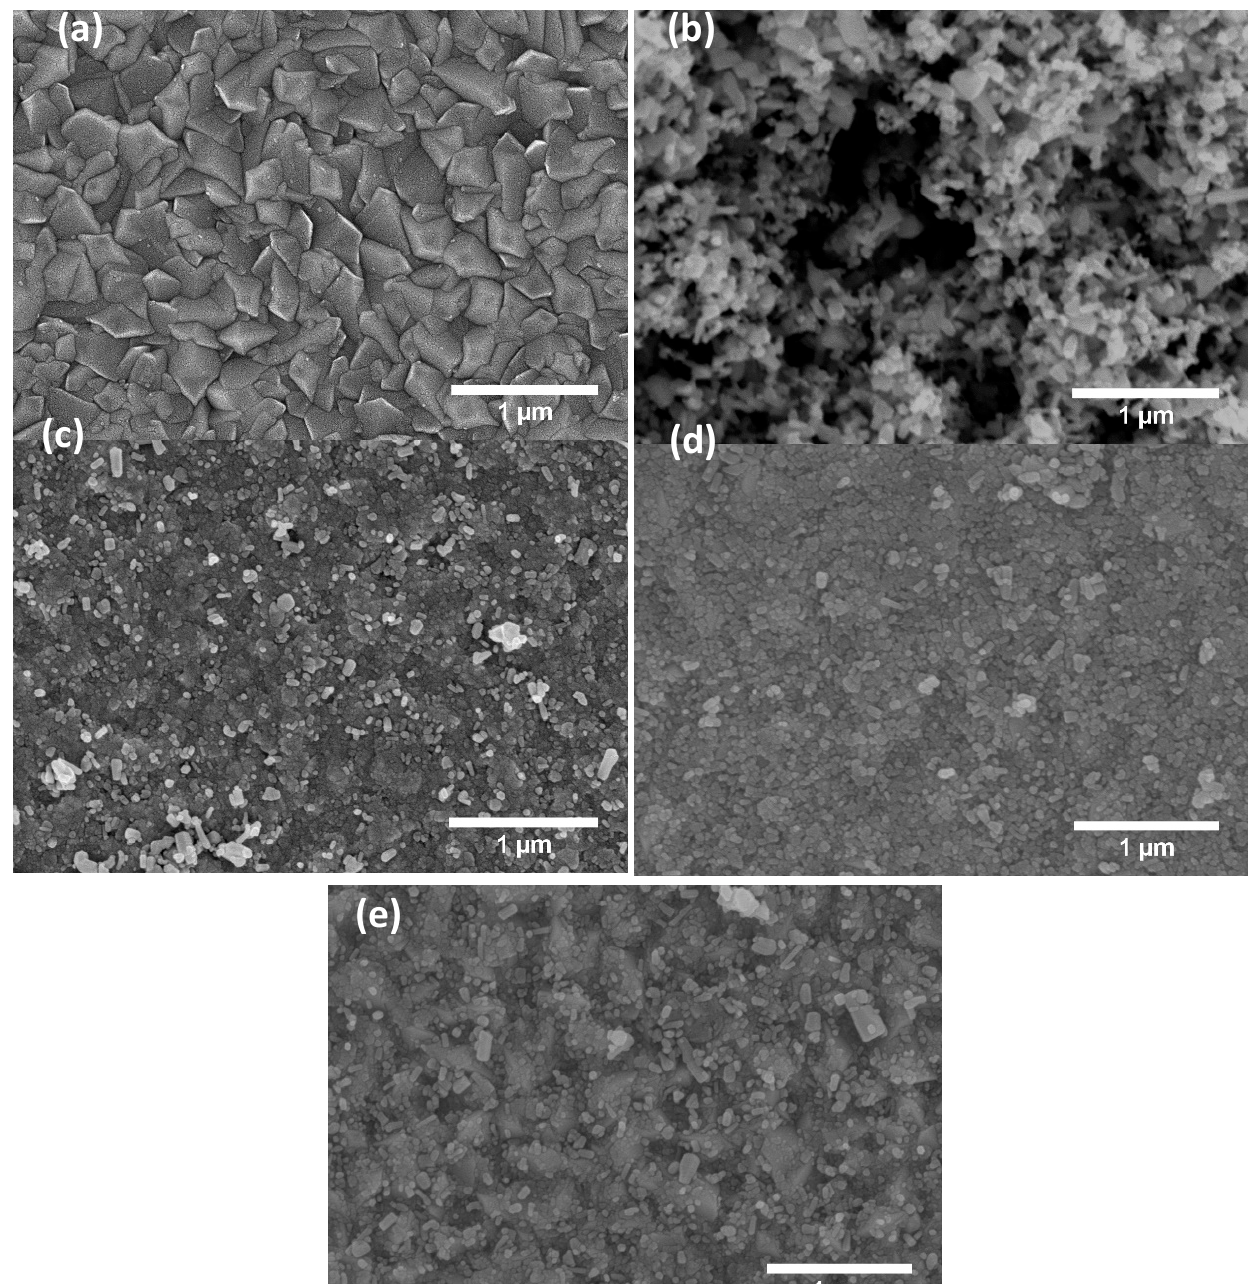
Figure 3. FESEM images of ( a ) bare FTO, ( b ) ZnO powder, ( c ) AD/Z-1, ( d ) AD/Z-2, and ( e ) AD/Z-3 on the FTO substrate at different AD flow rates.